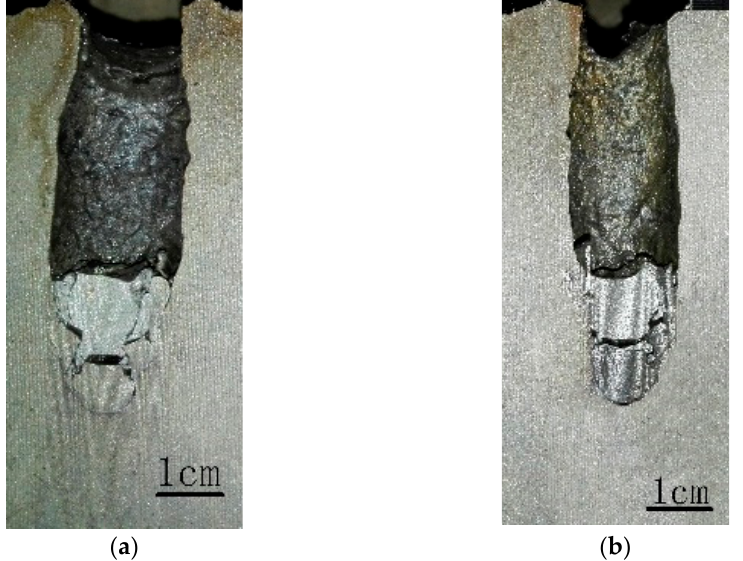
Figure 5. Longitudinal sections of craters penetrated by WHA rods. ( a ) v = 1447 m/s, ( b ) v = 1604 m/s.